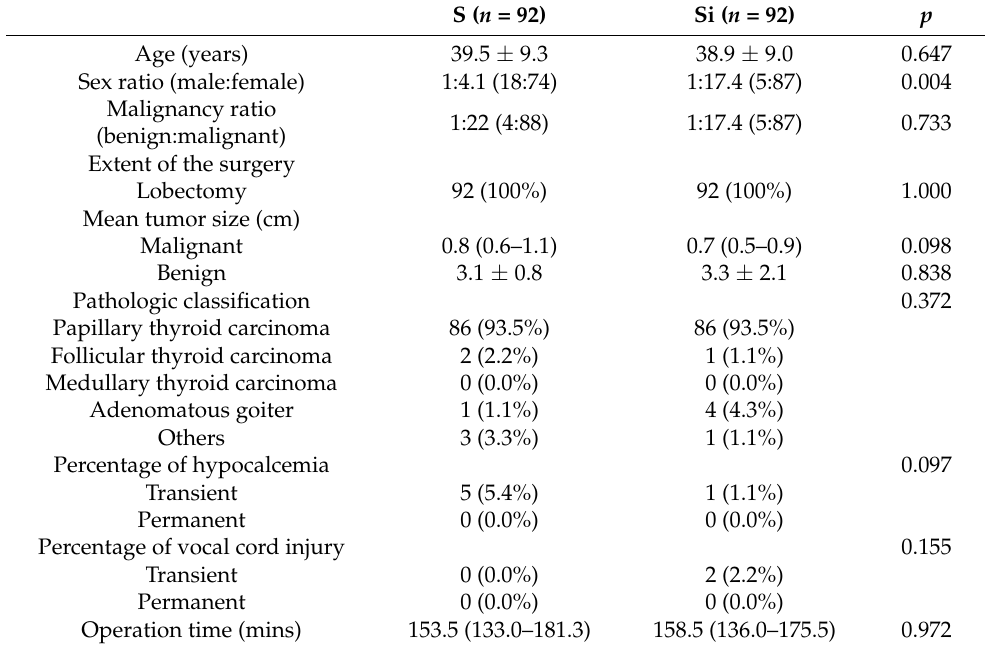
Table 2. Substudy A comparing da Vinci models S and